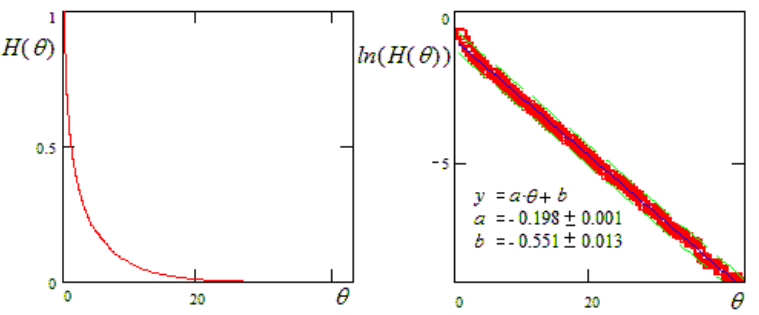
Figure 6: The fit of the cummulative distribution H ( θ ) of the switching time parameter θ for the noisy mean-field model in the monomer